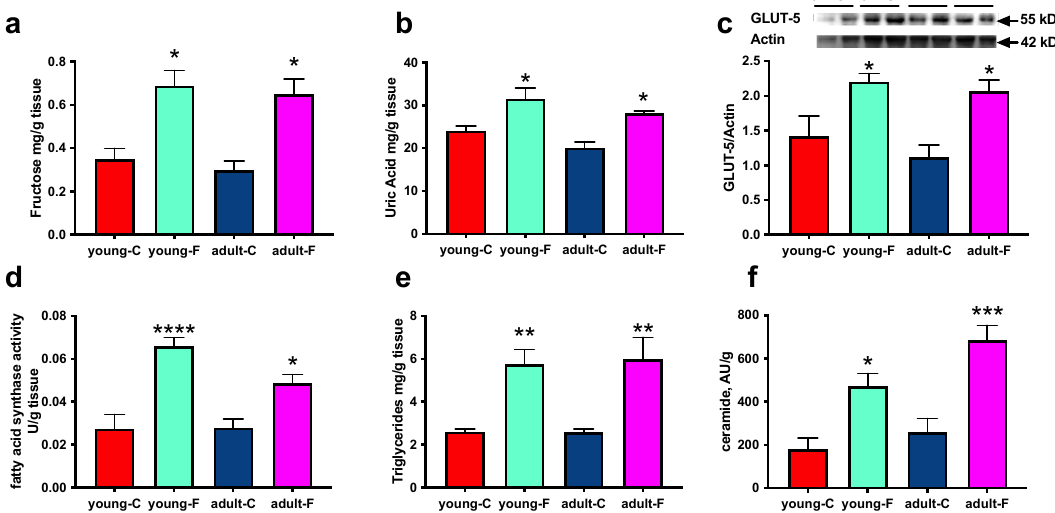
Figure 1. Skeletal muscle insulin signalling. ( a ) Skeletal muscle insulin sensitivity index, Western blot quantification (with representative Western blots) of ( b ) p-Akt, ( c ) p-GSK, ( d ) glucose transporter 4 (GLUT-4) and ( e ) content of glycogen in skeletal muscle in young and adult rats fed a control (young-C and adult-C) or fructose-rich diet (young-F and adult-F) for 2 weeks. Values are the means ± SEM of eight different rats. * p < 0.05, ** p < 0.01 compared to respective controls (two-way ANOVA followed by Tukey post-test).